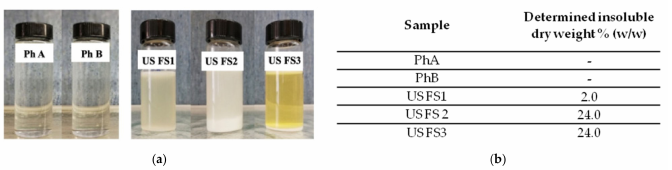
Figure 1. ( a ) Picture of the pharmaceutical products and US food supplement insoluble contents; ( b ) Determined insoluble dry weight table.